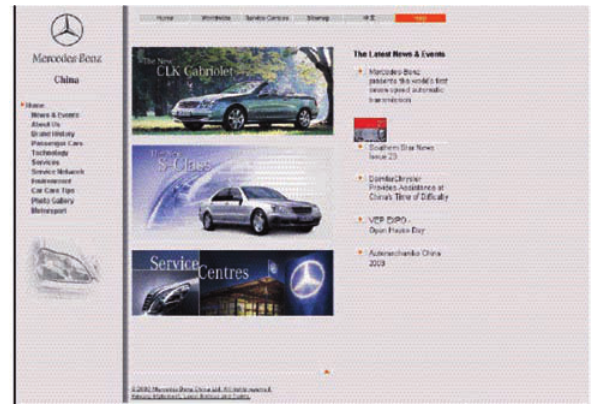
Fig 2. Mercedes-Benz China: Selling an opulent lifestyle